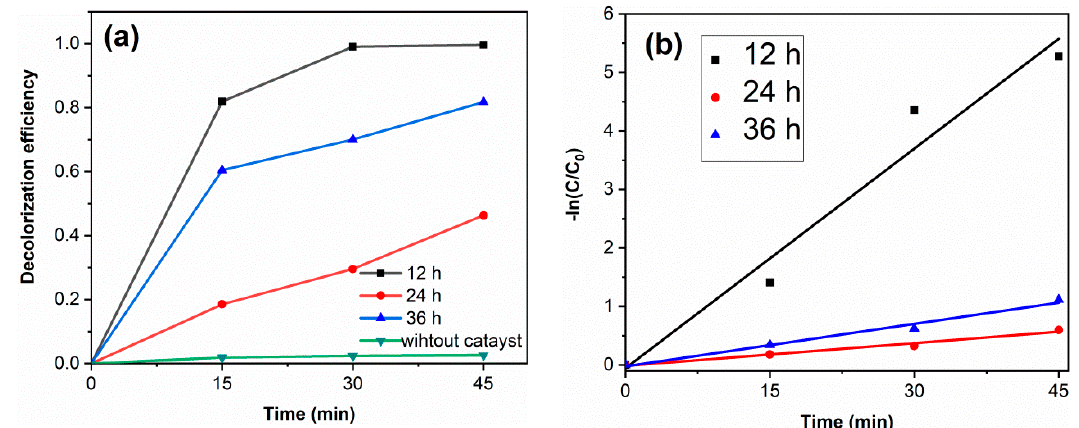
Figure 7. The RhB decolorization curves ( a ) and the kinetics fitting curves ( b ) of samples. (catalyst 0.1 g, RhB solution 100 mL (10 mg/L) and neutral pH). Table 2. The RhB decolorization data of TiO 2 photocatalytic materials prepared by hydrothermal method.